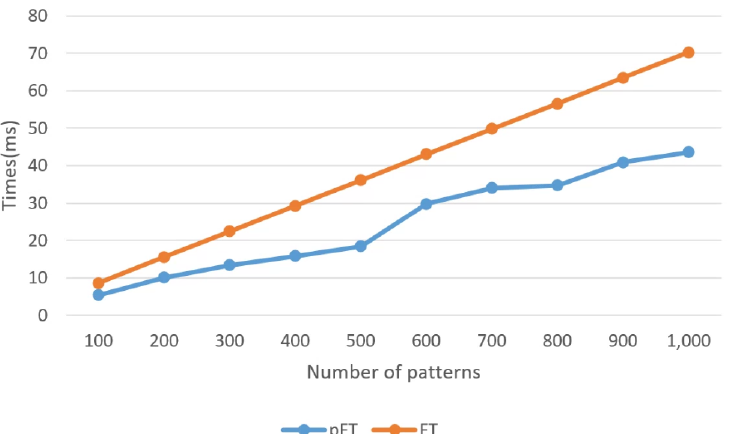
Figure 6. Comparison of execution times of FT and pFT according to k for randomly generated strings when n = 100,000 and m =